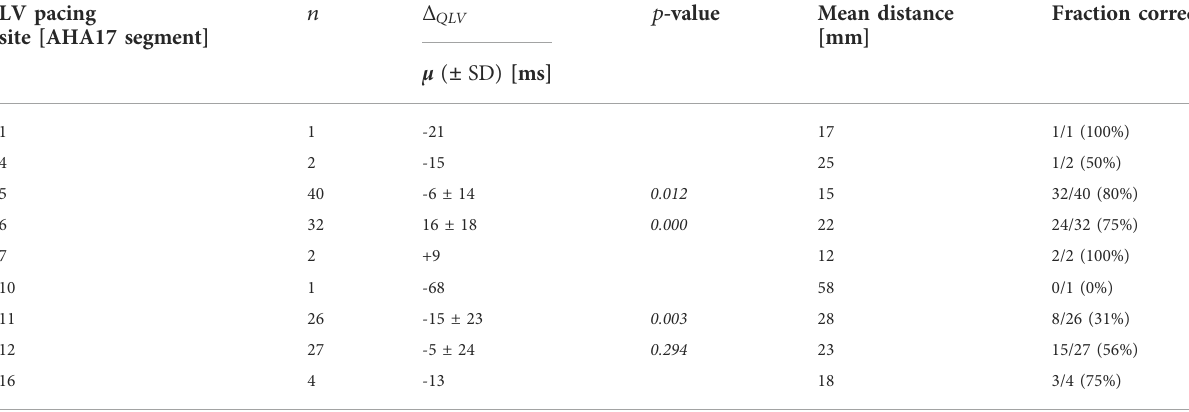
TABLE 2 Overall distribution of LV pacing site in terms of AHA17 segments and associated Δ QLV